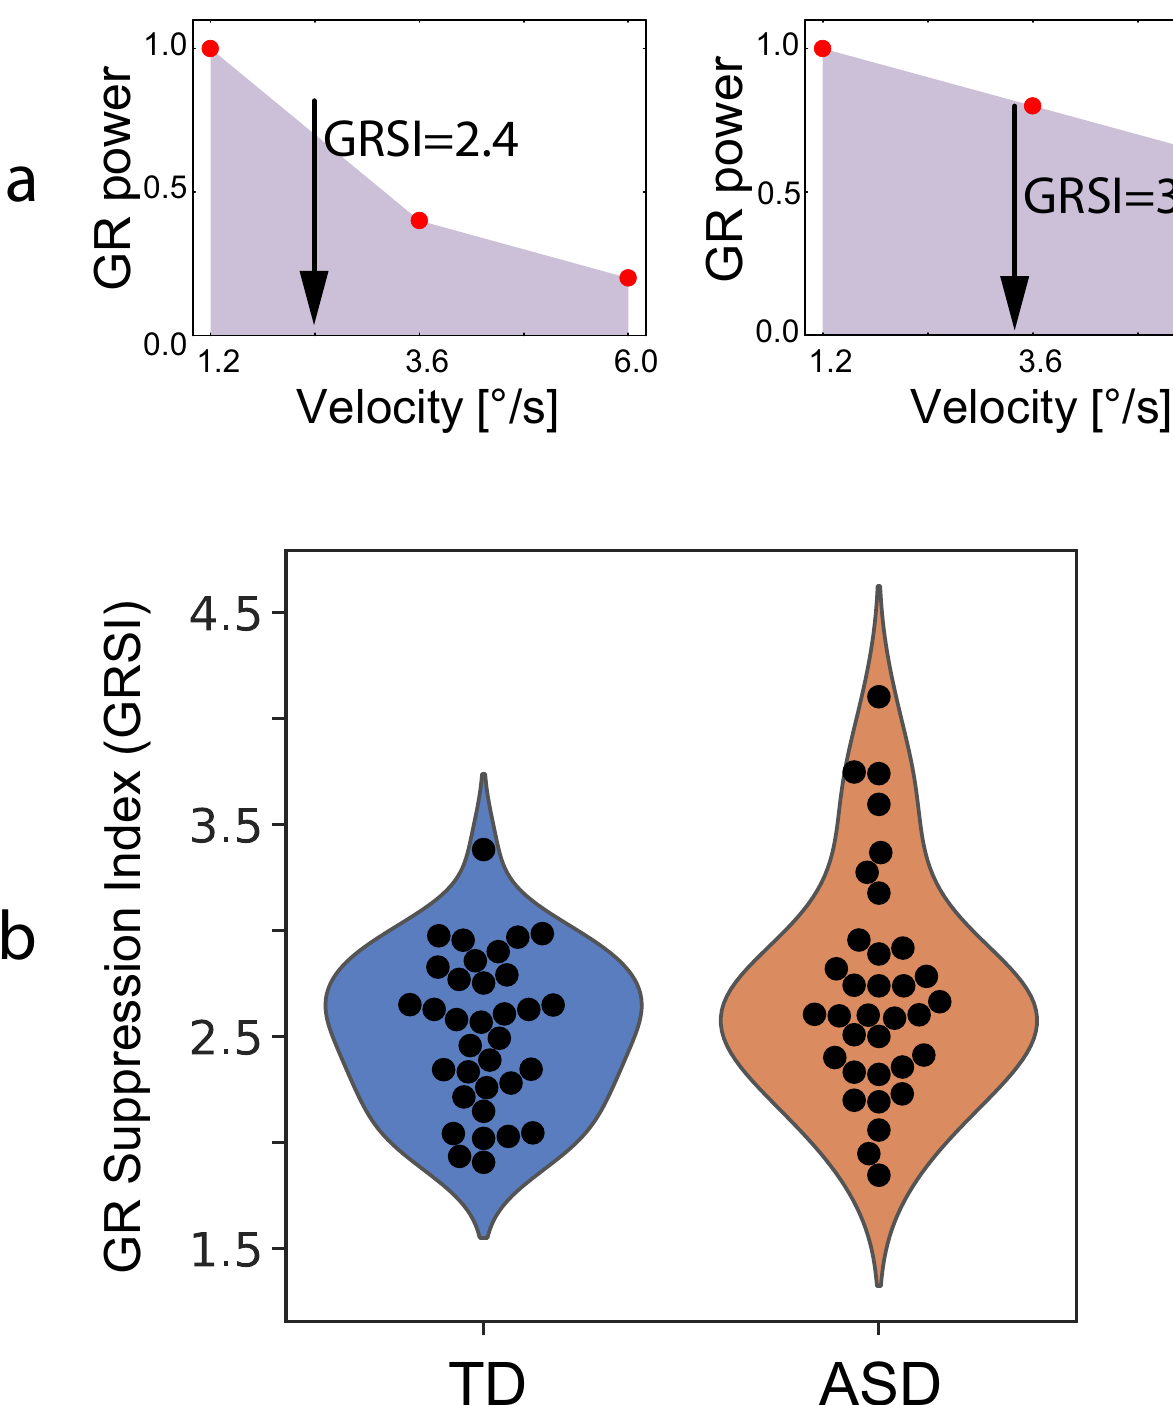
Fig 5. Gamma response suppression index (GRSI). (a) Schematic representation of the GRSI calculation. GRSI corresponds to the center of gravity indicated by an arrow: left/right panels show cases of strong/weak gamma response (GR) suppression, respectively. Higher GRSI value indicates weaker GR suppression with increasing visual motion velocity. (b) Individual variability of GRSI in the TD and ASD children: a